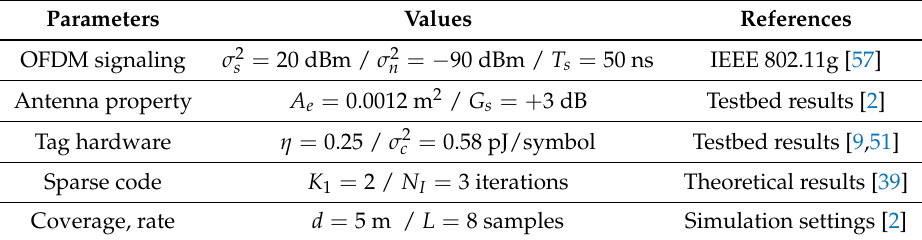
Table 3. System parameters.